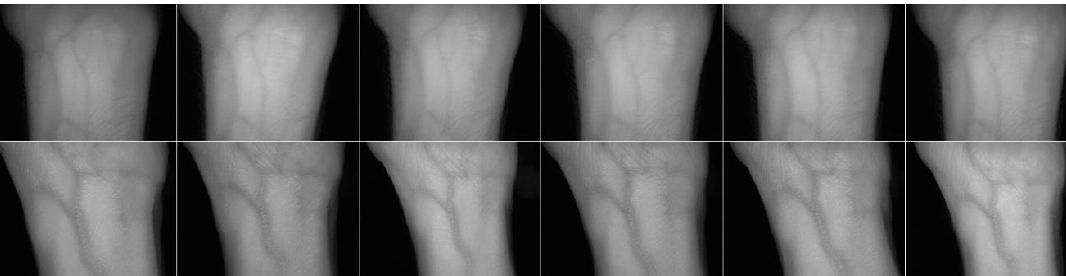
Figure 11. Three-Guideline Software for Contactless Vascular Biometric Recognition (TGS-CVBR ® ) images comparison for six samples of User 0 ( top row ) and User 82 (bottom row) [1].